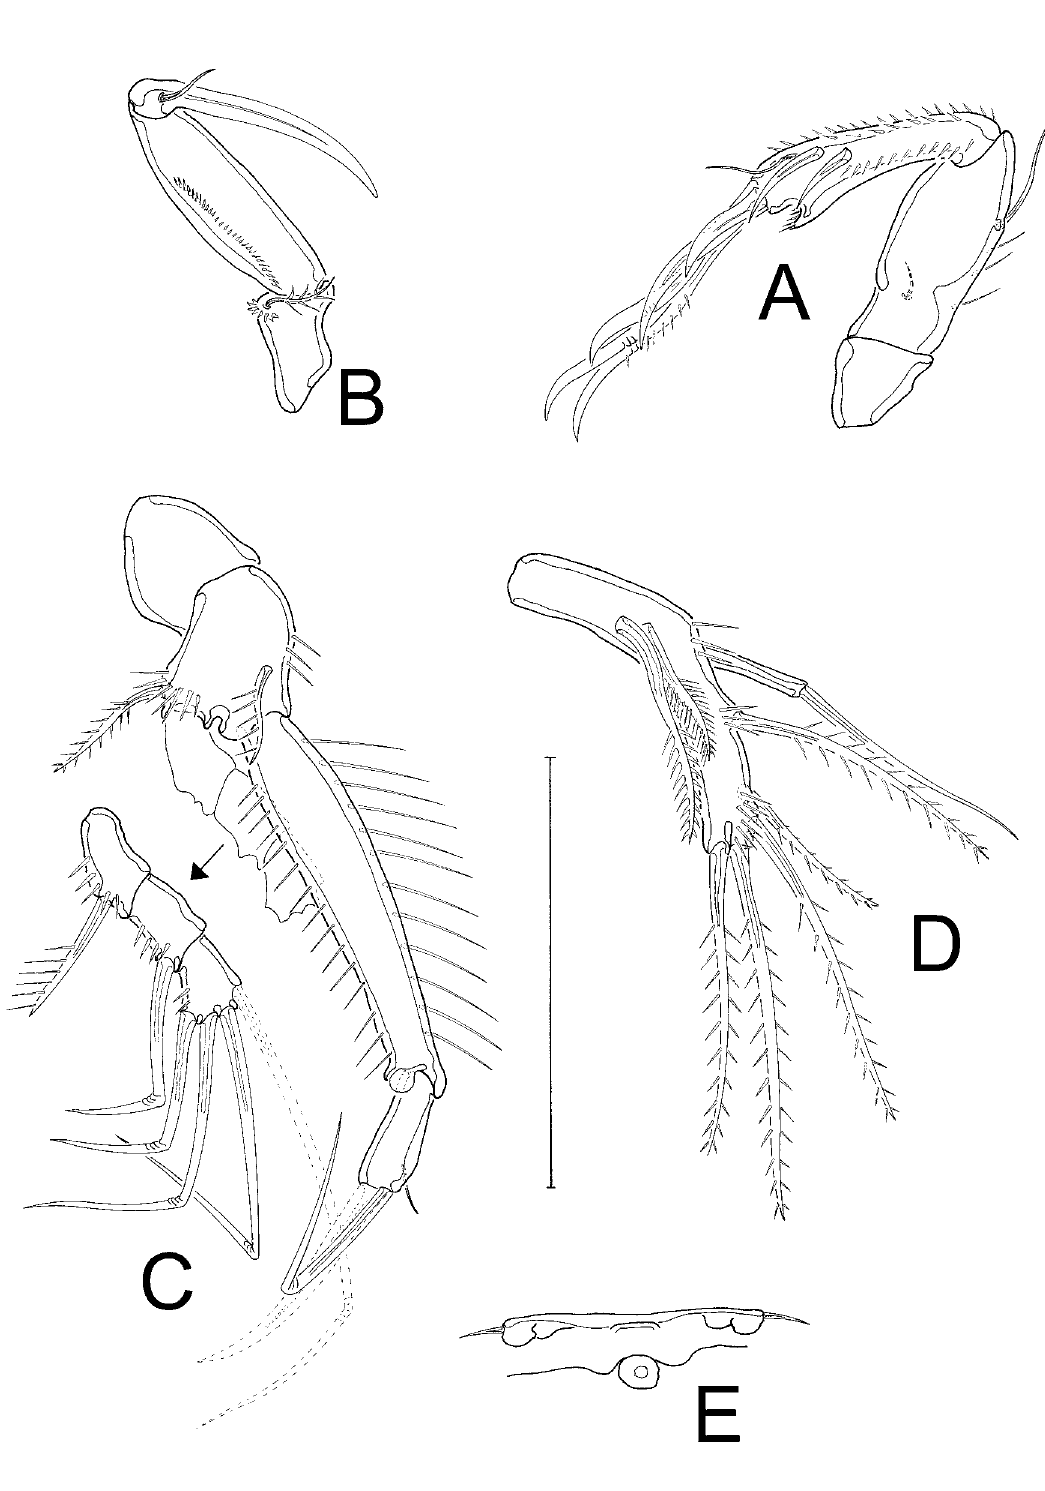
Fig. 10. Laophontodes sarsi sp. nov., paratype, ♀ (NHM F20298-2). A . A2. B . Mxp. C . P1, dotted elements according to counterpart. D . P5. E . GF with P6. Scale bar = 50